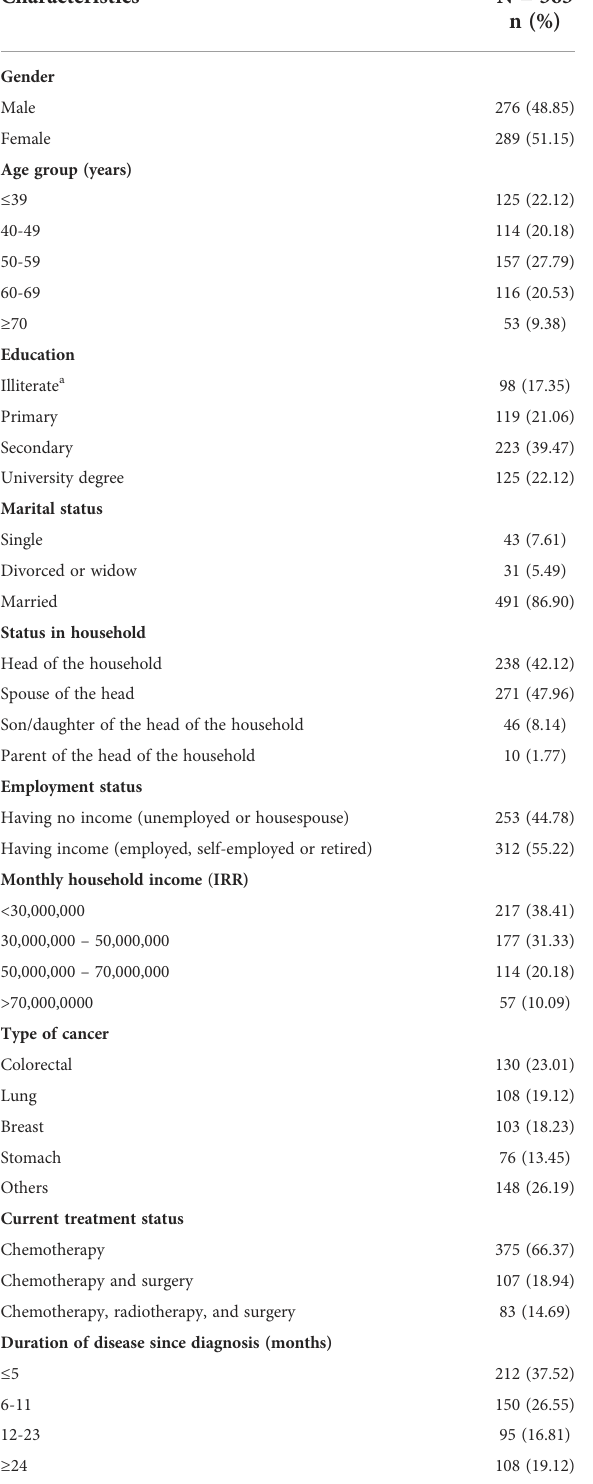
TABLE 1 Patients ’ characteristics (N=565).